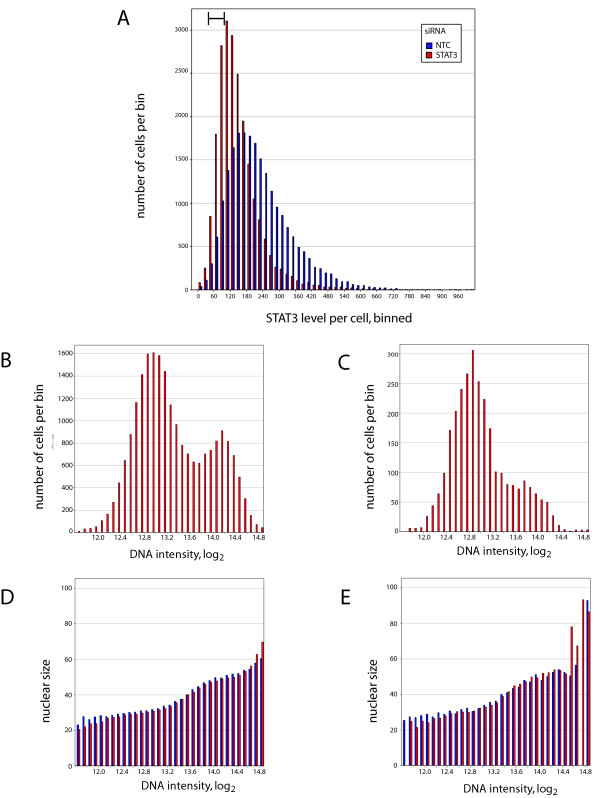
siRNA mediated knockdown of STAT3. A. Histogram of STAT3 levels in SW480 colon carcinoma cells treated with STAT3 and NTC (non-targeting) siRNAs. Red bars denote STAT3 siRNA treated cells and blue bars represent NTC treated cells. Data presents ~22,000 cells for samples treated with STAT3 and NTC siRNAs each. A region of low-STAT3 expressing cells examined in panels (C) and (E) is indicated in the panel (top left corner). B. DNA histogram of cells treated with the STAT3 siRNA. C. DNA histogram of low-STAT3 expressing cells (cells are highlighted in panel A). D. Nuclear size as a function of DNA content for the entire dataset. E. Nuclear size as a function of DNA content for the low-STAT3 cells highlighted in part A, for both STAT3 and NTC treated cells. The measure of DNA content for panels B-E are identical, and therefore the comparison of nuclear size as a function of DNA content may be made directly to the fraction of cells in each phase of the cell cycle (panels C and D, respectively). Color schemes for panels D and E are as in A.